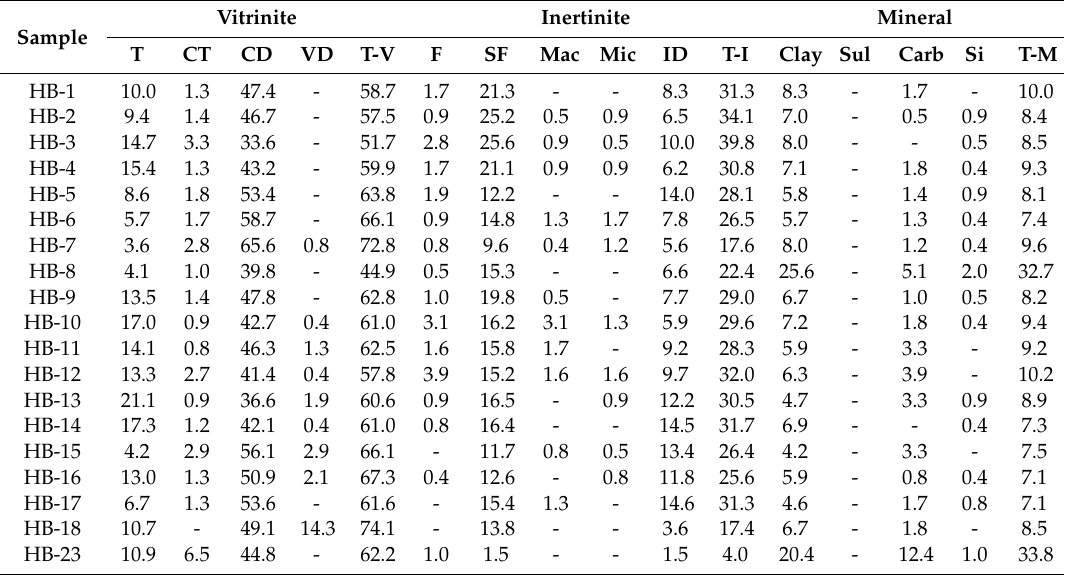
Table 3. Maceral composition (Vol.%) and mineral contents (Vol.%) of the No. 2 1 coal samples.